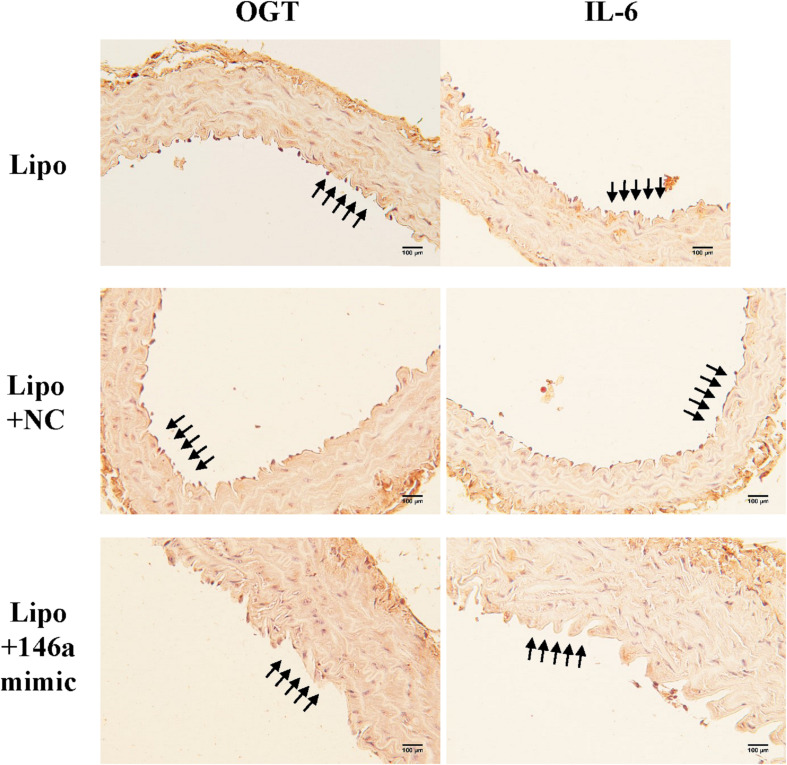
The miR-146a-5p mimic decreased endothelial OGT and IL-6 expression in type 2 db/db diabetic mice. Immunohistochemistry staining of OGT and IL-6 in thoracic aorta tissue. Representative images showed that the immunoreactivities of endothelial OGT and IL-6 in the aortic endothelial layers were decreased in the miR-146a-5p mimic-treated db/db mice, as compared to negative control (NC)-treated db/db or Lipo-treated db/db mice. N = 3 per group. Scale bar = 100 μm. Lipo, LipofectamineTM2000.